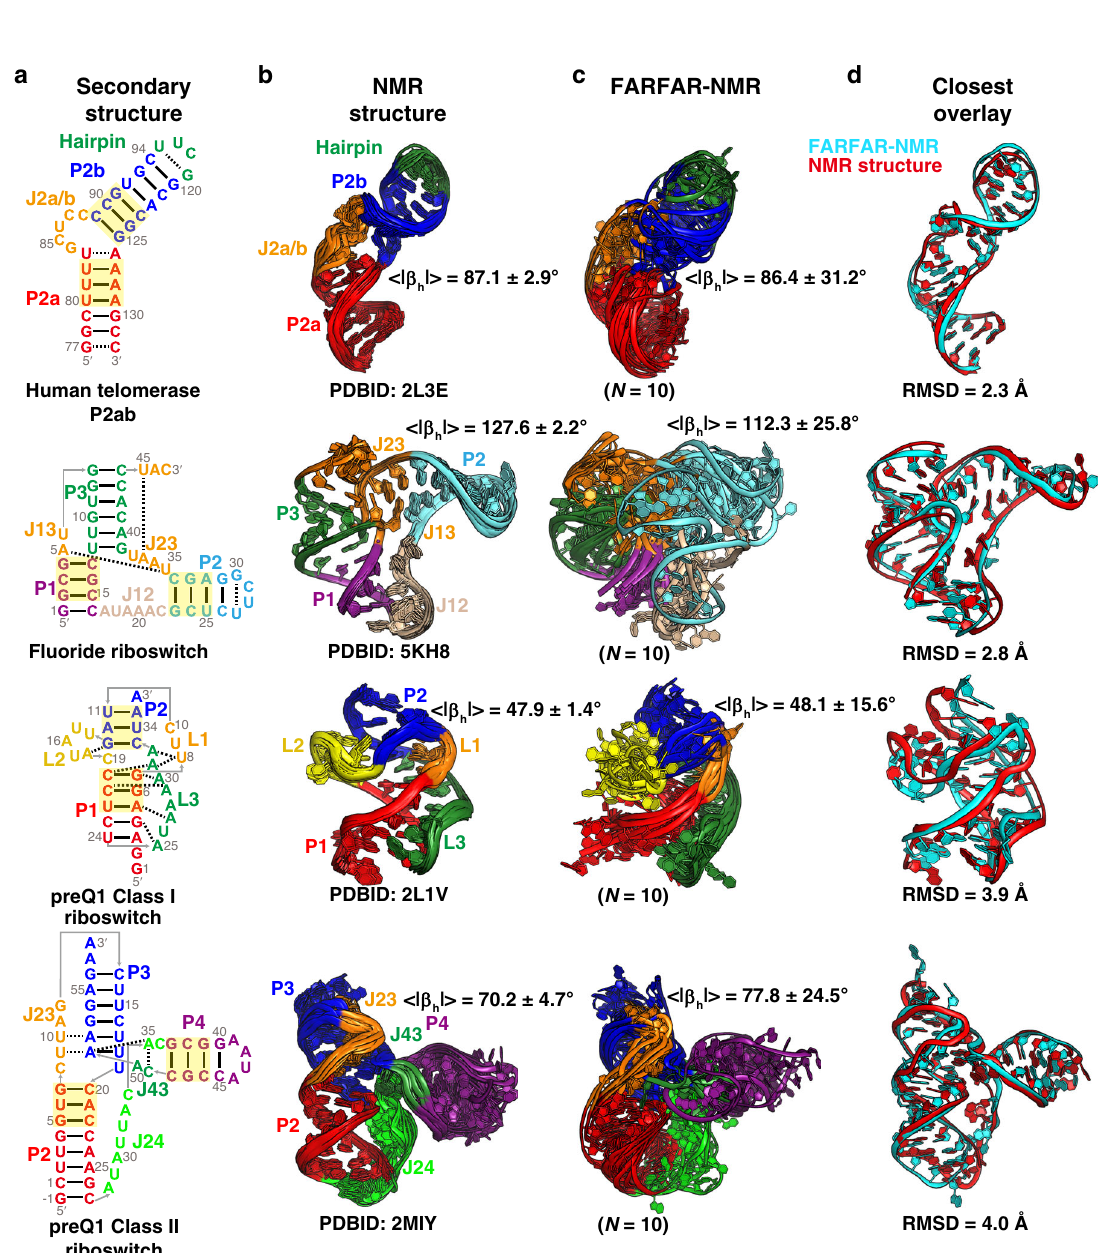
Fig. 7 Initial ensembles of various RNA. a The RNA secondary structure for each RNA from top to bottom: human telomerase P2ab, fl uoride riboswitch, preQ1 Class I riboswitch and preQ1 Class II riboswitch. The bps at different helices used for de fi ning the Euler angles are highlighted in yellow. b The NMR structure bundles. c The FARFAR-NMR ensembles with ensemble size ( N ) labeled below. Different structural elements are color-coded according to a . The average bend angles < | β h |> ( N = 10 × 200 = 2000) of the two helices are labeled along with the ensembles. d Comparison of the FARFAR-NMR conformer (cyan) with the closest heavy-atom RMSD to the NMR structure